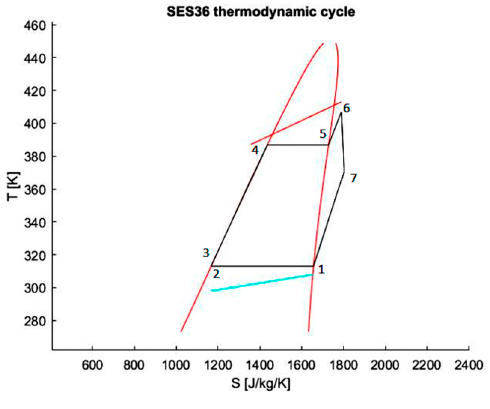
Figure 7. SES36 T – S diagram. Table 6. E ffi ciency, mass flow rate and expansion ratio for the considered fluids. Table 5. SES36 thermodynamic parameters.